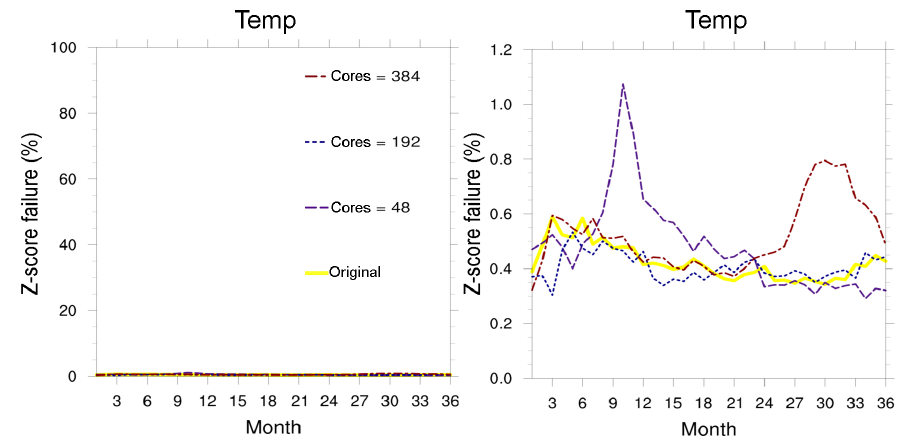
Figure 7. Percentage of grid points with Z -scores for temperature (TEMP) that exceed the 3.0 tolerance for simulations with various numbers of processor cores. (Note that the left and right panels contain the same information, with different scales for the y